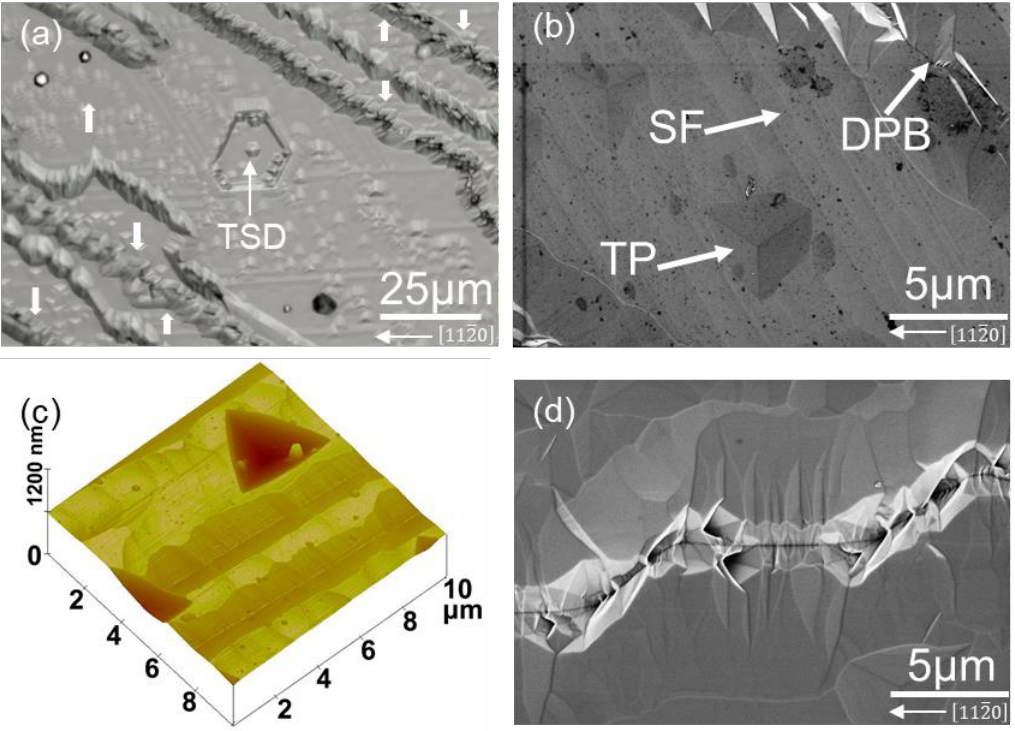
Figure 4. Images of the etched surface of the sample at a T g of 1650 °C ( a ) Nomarski photograph, ( b , d ) SEM images, ( c ) 3D AFM image.